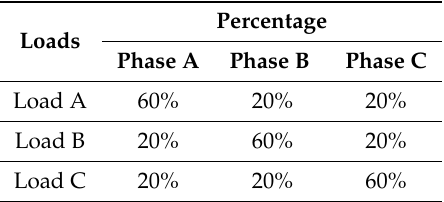
Table 3. Form “B” of the load by phase distribution.